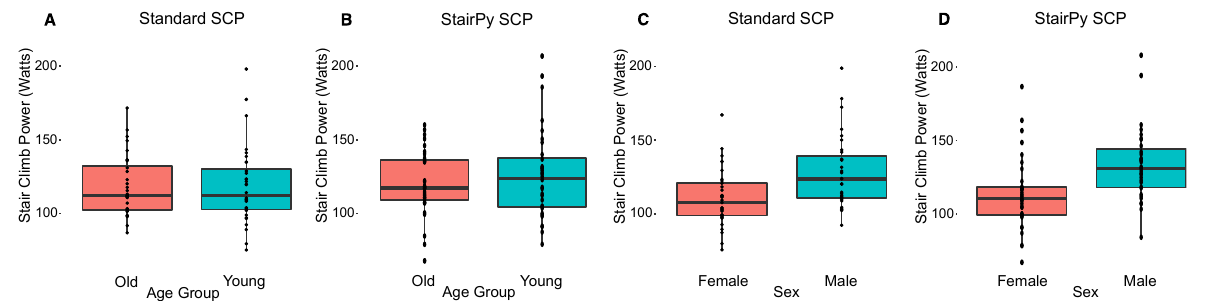
Figure 4. ( A ) Comparison of StairPy derived stair climb power (SCP) and Standard SCP calculation. The stair climb powers were highly correlated (Pearson’s r = 0.92, p < 0.001. ( B ) Bland Altman (Standard SCP—StairPy SCP) showed minimal mean difference (mean difference = − 4.11, blue solid line; LoA = [ − 24.9, 16.7], green solid line; zero bias reference line (mean difference = 0), red solid lines; corresponding confidence intervals are dashed lines).